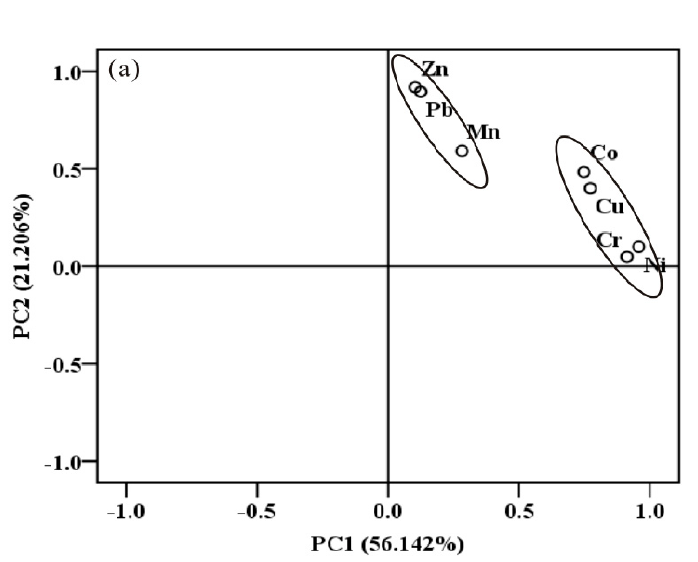
Figure 5. The principal component analysis results heavy metals. ( a ) Factor loadings; ( b ) factor scores.